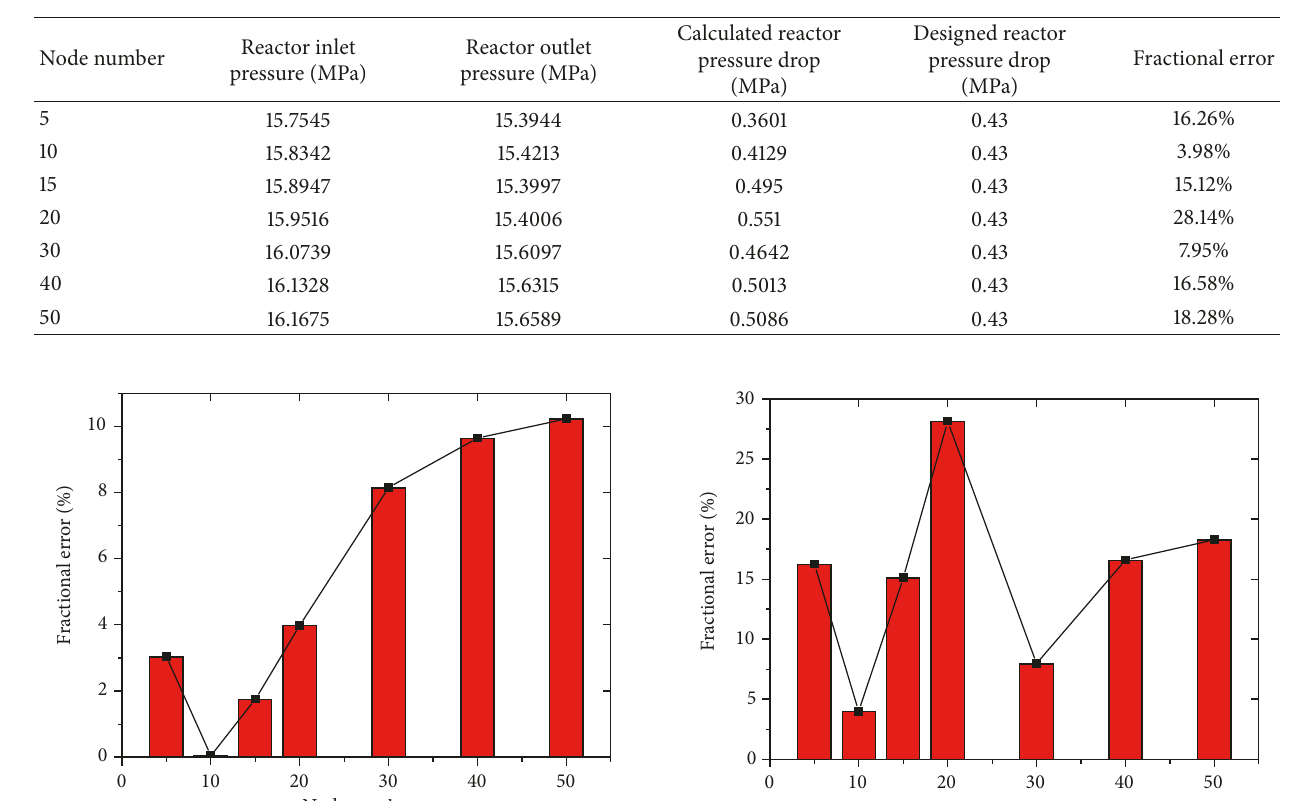
Table 2: The influence of core channel node number on the reactor pressure drop.